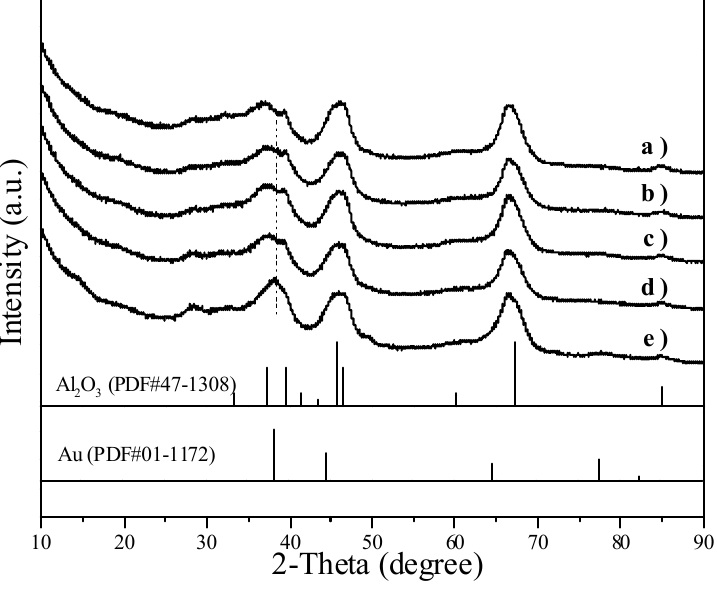
Figure 6. XRD patterns showing (a) Al particle sizes: (b) 2.0 nm; (c) 3.4 nm; (d) 5.7 nm; (e) 8.7